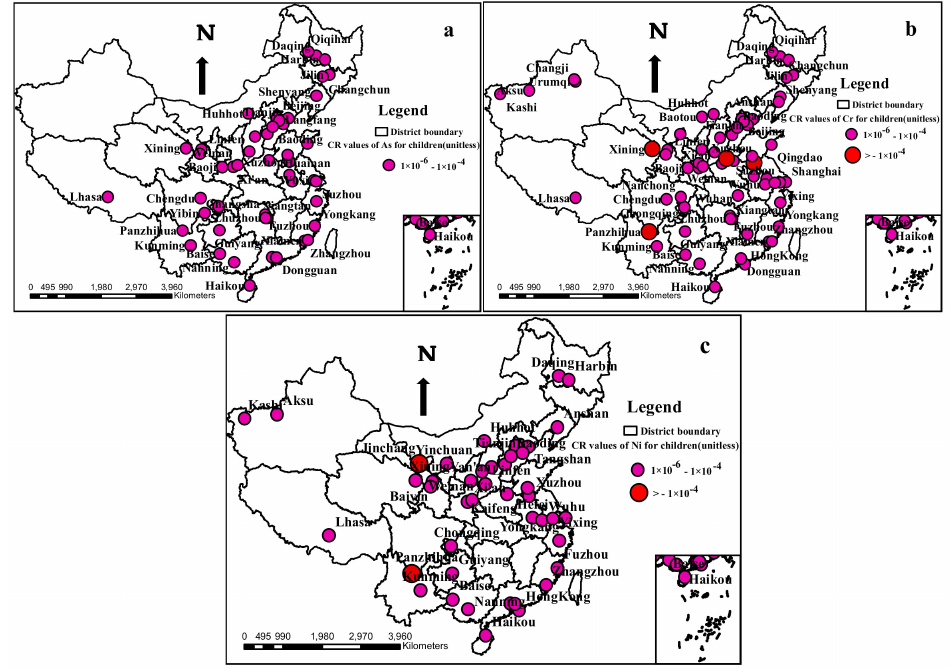
Figure 6. The distribution of the carcinogenic risks ( CR ) of As, Cr and Ni for children in urban soils around China. ( a ): The distribution of CR of As for children in urban soils around China. ( b ): The distribution of CR of Cr for children in urban soils around China. ( c ): The distribution of CR of Ni for children in urban soils around